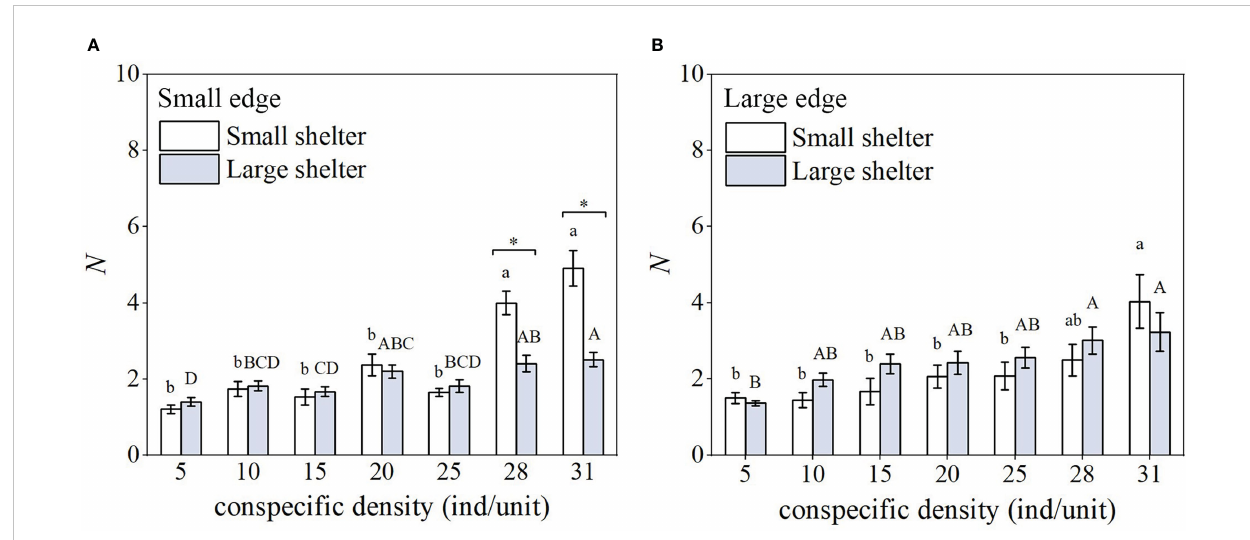
FIGURE 4 Number of occupants ( N ) (n = 6, mean ± SE) under the seven density treatments in the reef unit with (A) small edge and (B) large edge. Different lower-case letters represent signi fi cant differences among densities for the small shelter (Tukey ’ s test, p < 0.05); different capital letters represent signi fi cant differences among densities for the large shelter (Tukey ’ s test, p < 0.05); * indicates a signi fi cant difference between small shelter and large shelter for same density and edge (Tukey ’ s test, p < 0.05).